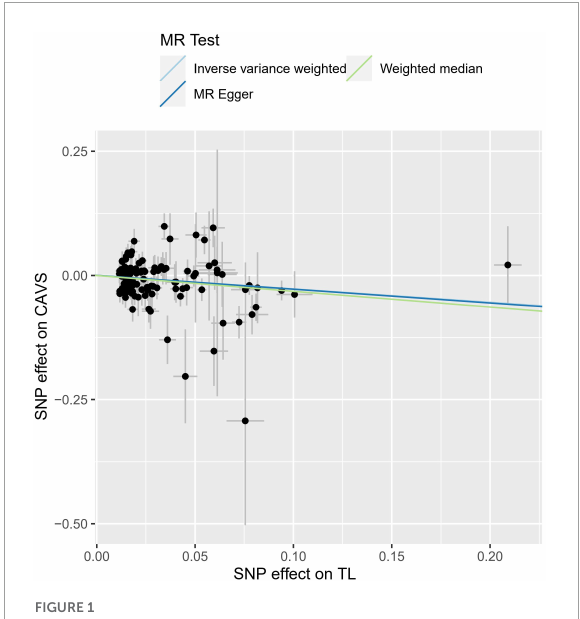
FIGURE1 Individual estimates about the causal effect of telomere length (TL) on calcific aortic valve stenosis (CAVS). The X -axis shows the single nucleotide polymorphism (SNP) effect and standard error (SE) on each of the 118 TL SNPs from Integrative Epidemiology Unit (IEU) OpenGWAS dataset (https://gwas.mrcieu.ac.uk/datasets/ieu-b-4879). The Y -axis shows the SNP effect and SE on CAVS from FinnGen Project Database (https://r7.finngen.fi/). The regression lines for the MR-egger, weighted median, inverse variance weighted (IVW) method are shown. TL, telomere length; CAVS, calcific aortic valve stenosis; SNP, single nucleotide polymorphism; SE, standard